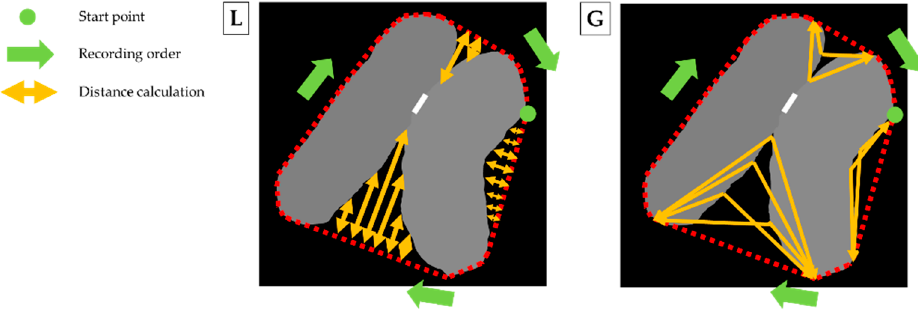
Figure 12. Illustration of two different types of time-series data L and G.